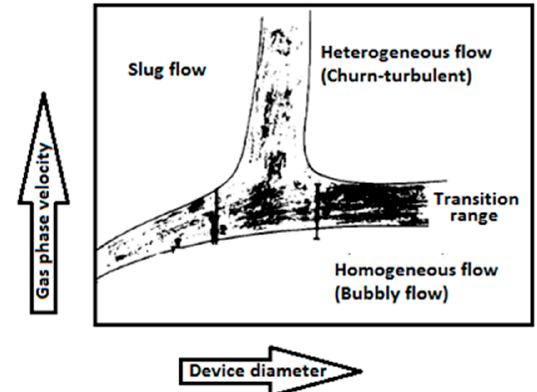
Figure 3. Characterizing the flow regimes in two-phase and slurry column reactors as a function of inlet gas velocity and scrubber dimension [36].